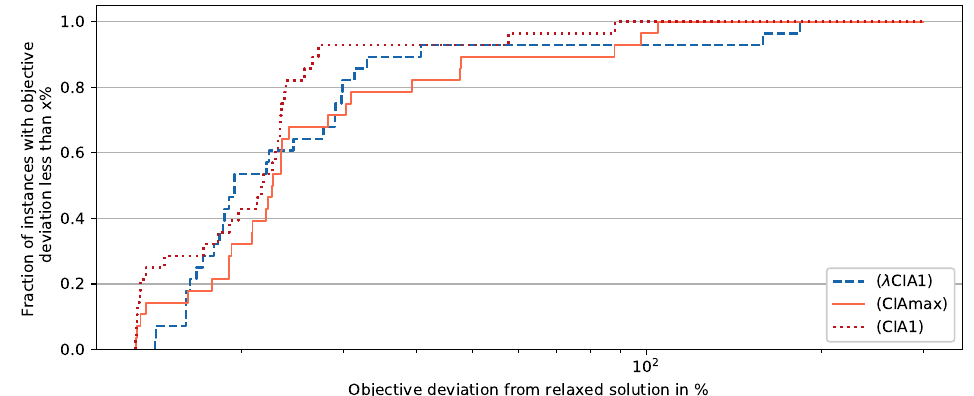
Figure 4. Performance profile comparing objective deviation from the relaxed solution in percentage and log-scale of λ -CIA and CIA solutions. The results are based on the instance “Quadrotor (binary variant)” from the mintoc.de benchmark library. ( λ CIA) appeared to provide no clear improvement compared with the (CIA) solutions.